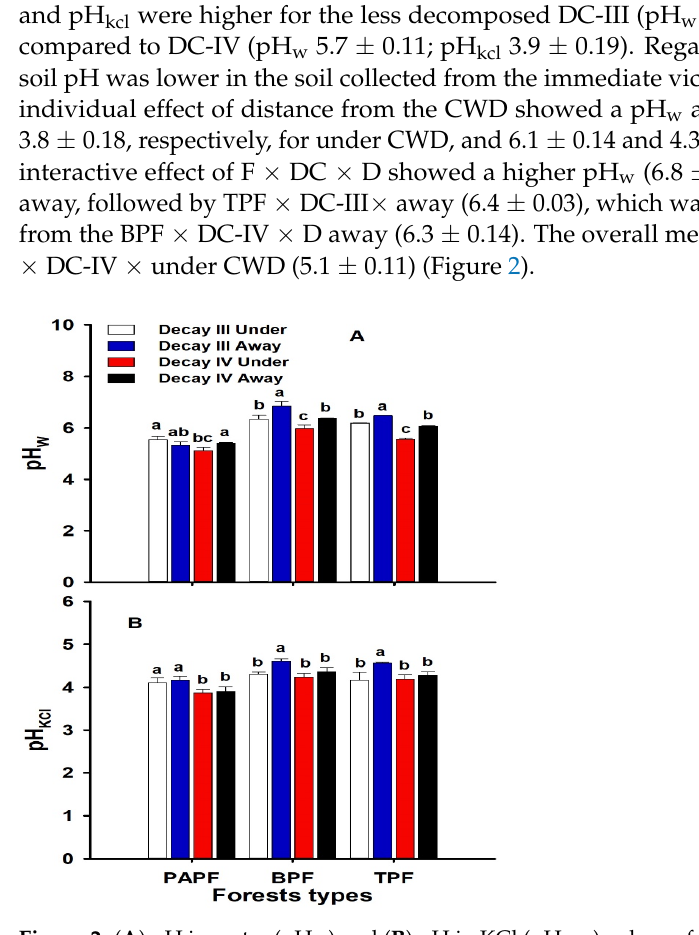
Figure 2. (A) pH in water (pH w ) and ( B ) pH in KCl (pH KCl ) values of the same dominant tree species PK with different decay classes at different distances in contrasting forest types of PAPF, BPF and TPF forest types in northeastern China. Significant changes between treatments within the same forest type are denoted by various lowercase letters. Tukey’s honest significant difference (HSD) post hoc; p < 0.05, mean ± SE = 3; the bars show standard errors.